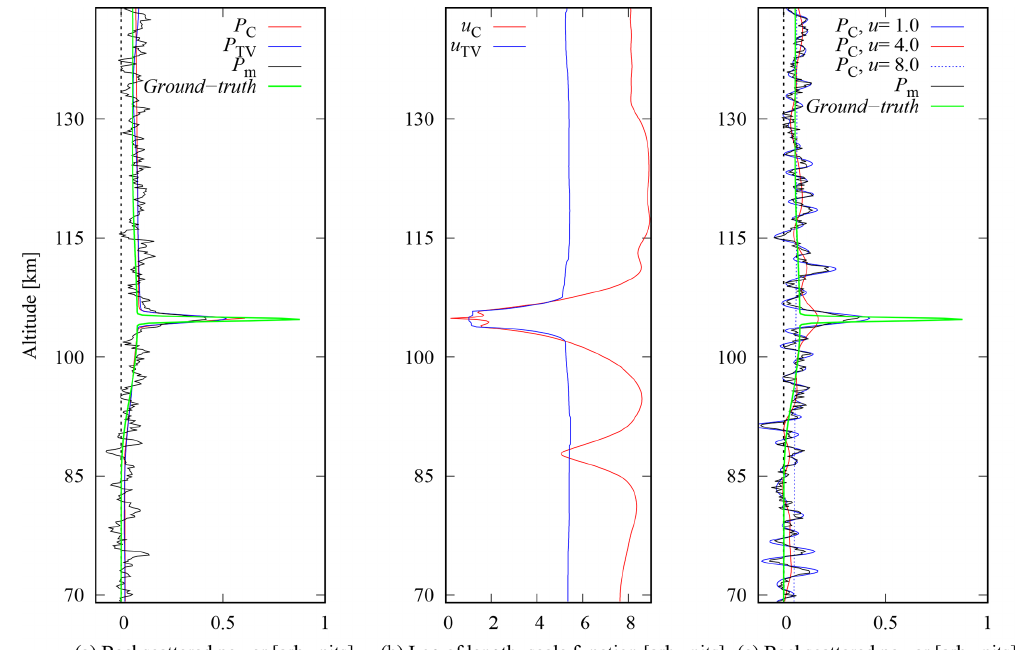
Figure 3. Synthetic power profile reconstruction and true power profile (green line). Panel (a) represents the comparison of Cauchy difference prior (red line) with tuning parameter α C = 3 . 0 and TV (blue line) prior, with α TV = 5 . 0. Corresponding length-scale functions in (b) . Panel (c) represents the reconstruction for the Cauchy difference prior for the fixed values of the length-scale function.